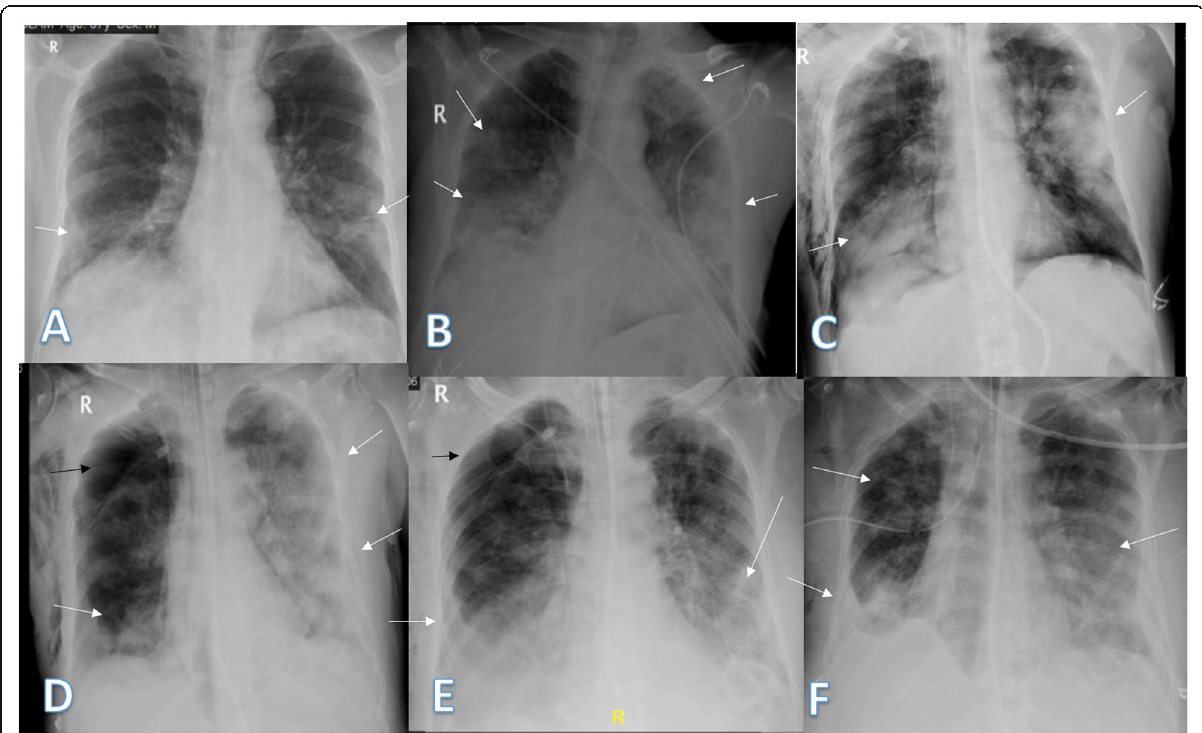
Fig. 18 67-year male with positive COVID-19 virus. Initial X-ray ( a ) showed small right and left lower zonal midzonal air space consolidation opacities (arrows) with TSS as 2. On the 3rd day ( b ), air space consolidation opacities increased extended to involve most of the left lung and the lower zone of the right lung with midzonal patches (arrows); TSS reached 5 (3 on LT side and 2 on right side). The patient deteriorated and was hypoxemic, so he was intubated. On the 7th day ( c ), the patient developed pneumothorax and ICT was inserted. On the 9th day ( d ), 13th day ( e ), and 16th day ( f ), there was air space consolidation (arrows) more on the left lung with mild pneumothorax (black arrows on d and e ). Minimal right pleural effusion was seen on (short arrows on e and f ). The total severity score was 6 on d – f ; the patient died